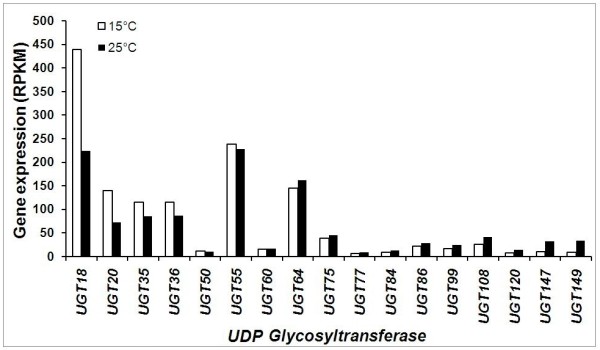
Reads per exon kilobase per million (RPKM) values-based expression analysis of uridine diphosphate glycosyltransferases (UGTs) in P. kurrooa transcriptome. Expression of 17 UGTs was studied at 15°C and 25°C. Details of the corresponding contigs, accession number and BLAST are listed in Additional file 15.